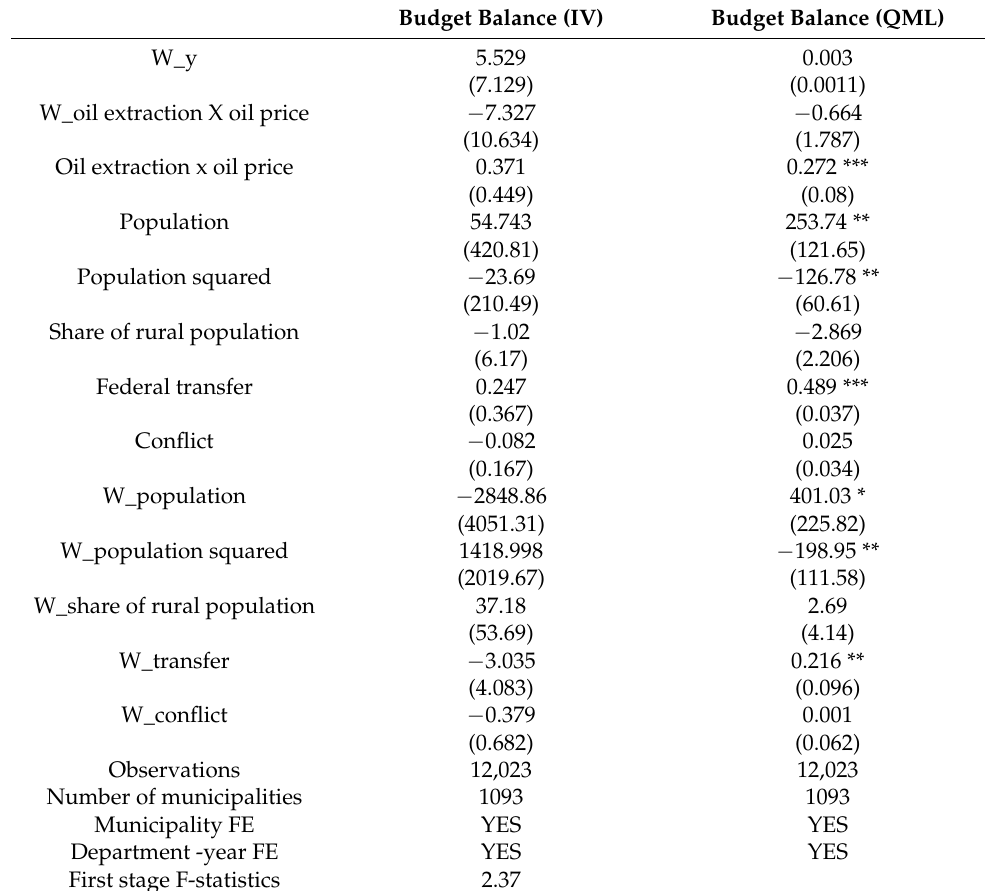
Table 6. Robustness checks: using inverse hyperbolic sine (IHS)